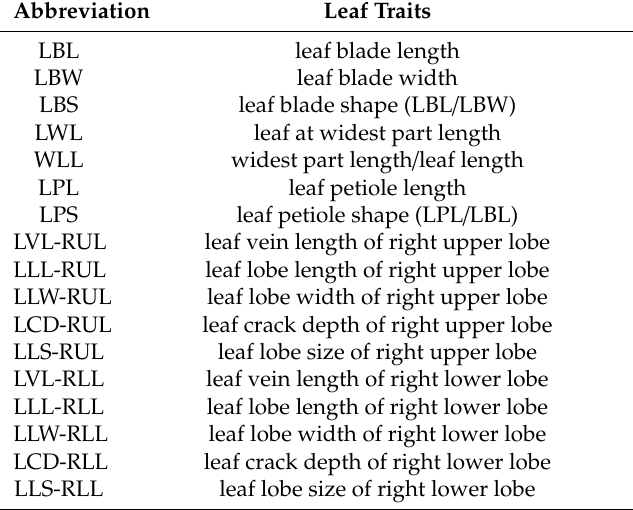
Figure 1. Leaf morphology of two hybrid parents. ( a-1 ) Female parent “388Q-76” of cross I; ( a-2 ) male parent “Hongchi” of cross I; ( b-1 ) female parent “Candy” of cross II; ( b-2 ) male parent “225” of cross II. Scale is 1 cm. Table 1. Abbreviations for 17 leaf measured